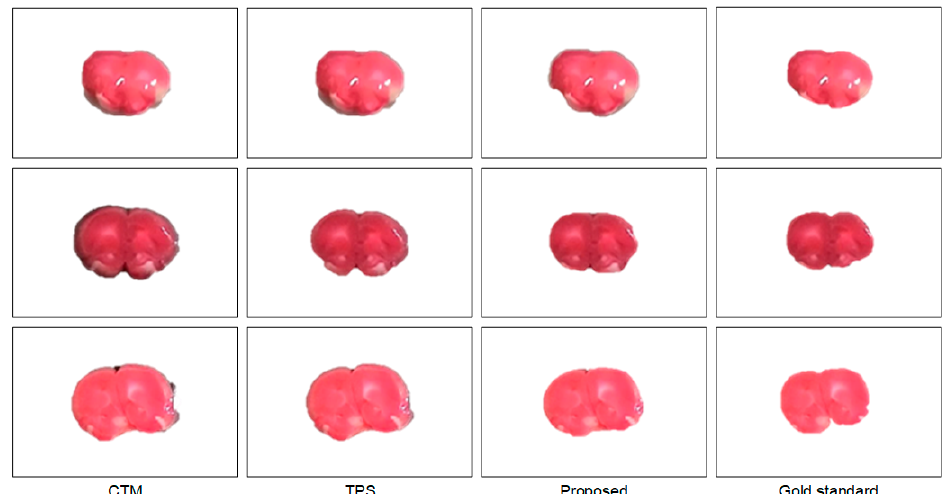
Figure 5. Visual comparison of brain extraction results in rat TTC-stained images using different methods. Top row: slice 1 of Subject 2. Middle row: slice 2 of Subject 20. Bottom row: slice 3 of Subject 37.